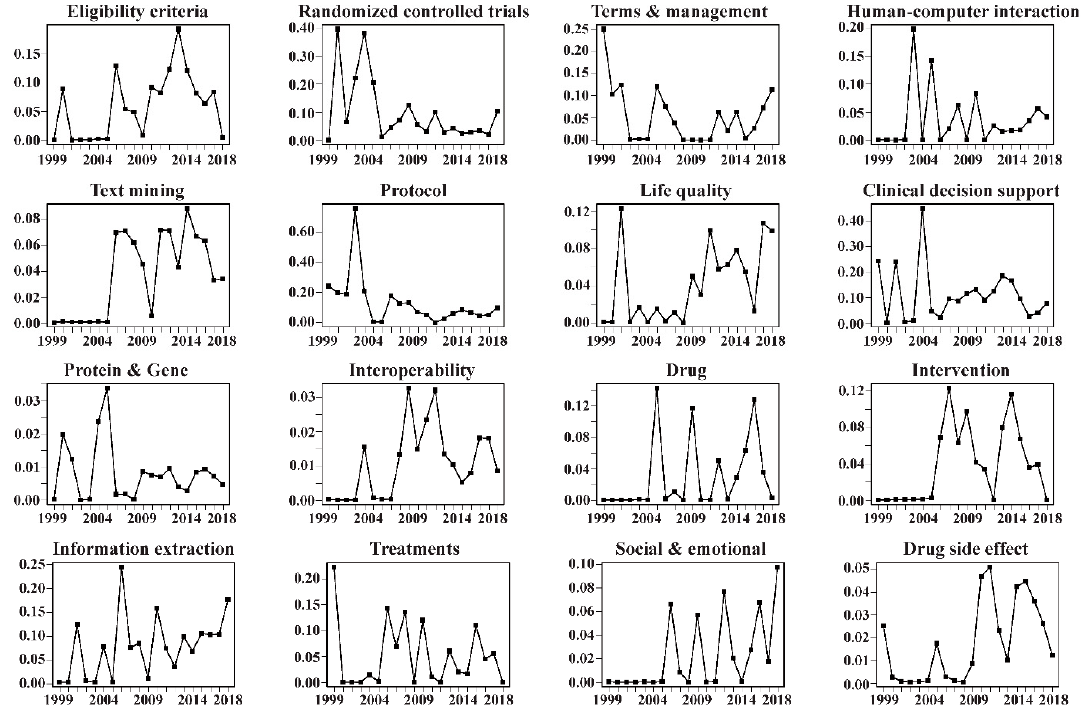
Figure 7. Temporal trends of the 16 topics in the whole corpus (2009–2018). Table 10. The 16 structural topic modeling (STM) results with the discriminating terms, topical proportions, suggested topic labels, and trend test results.